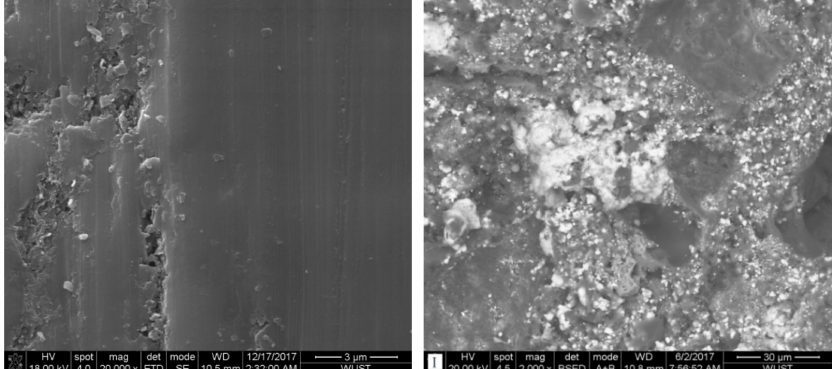
Figure 4. SEM images before ( left ) and after ( right ) the reaction of the coke